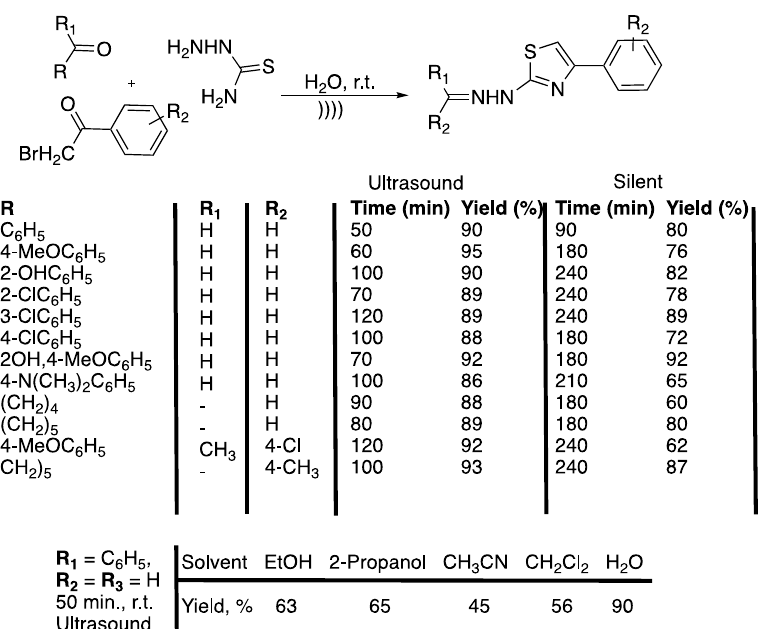
Scheme 8. One-pot, three-component, catalyst-free synthesis of N-(4-arylthiazol-2-yl) hydrazones in water under ultrasonic irradiation. The ultrasonic cleaner bath used f = 25 kHz, P input = 250 W, and T